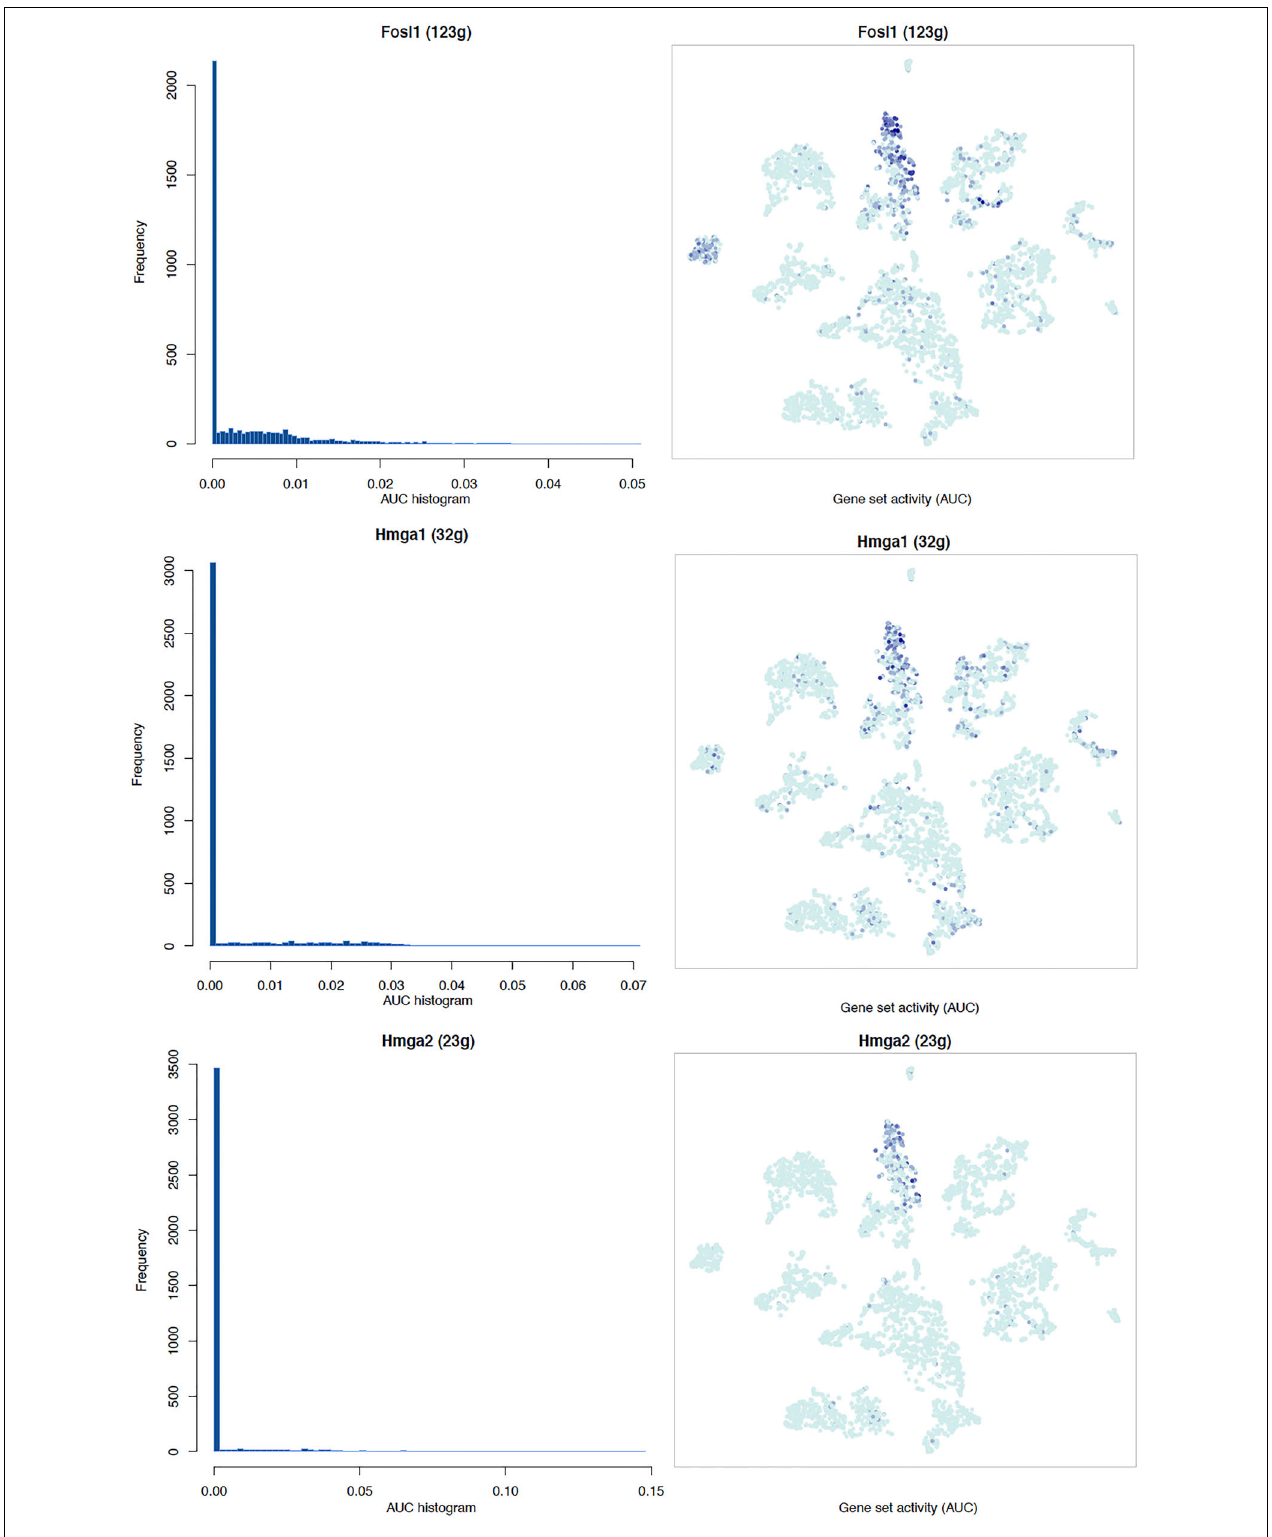
FIGURE 9 | tSNE plots overlayed with regulon activity and histograms showing the distribution of regulon activity of Fosl1, Hmga1, and Hmga2 in day 9 scRNA-seq data set.